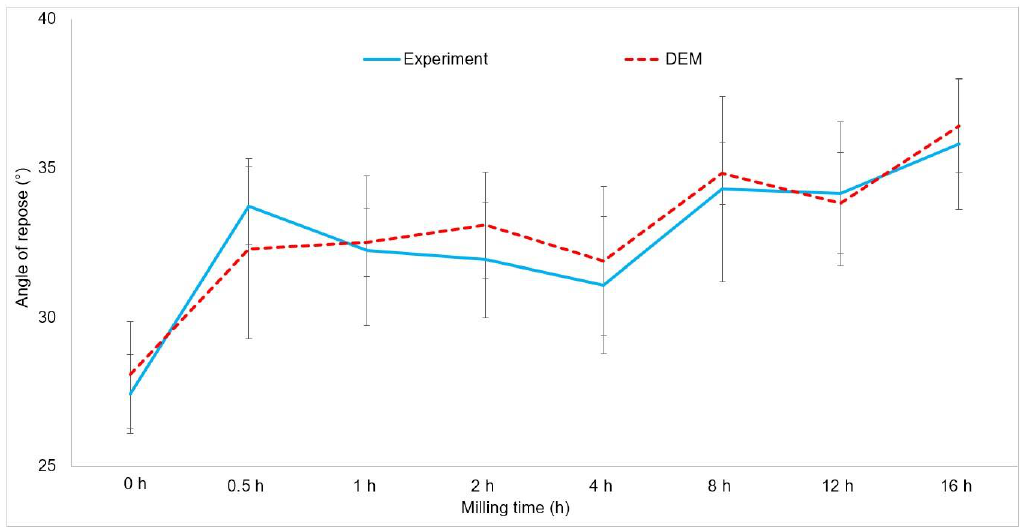
Figure 16. Angle of repose of the as-received powder and milled Gr/AA2024 obtained from experi- mental work and DEM simulation.